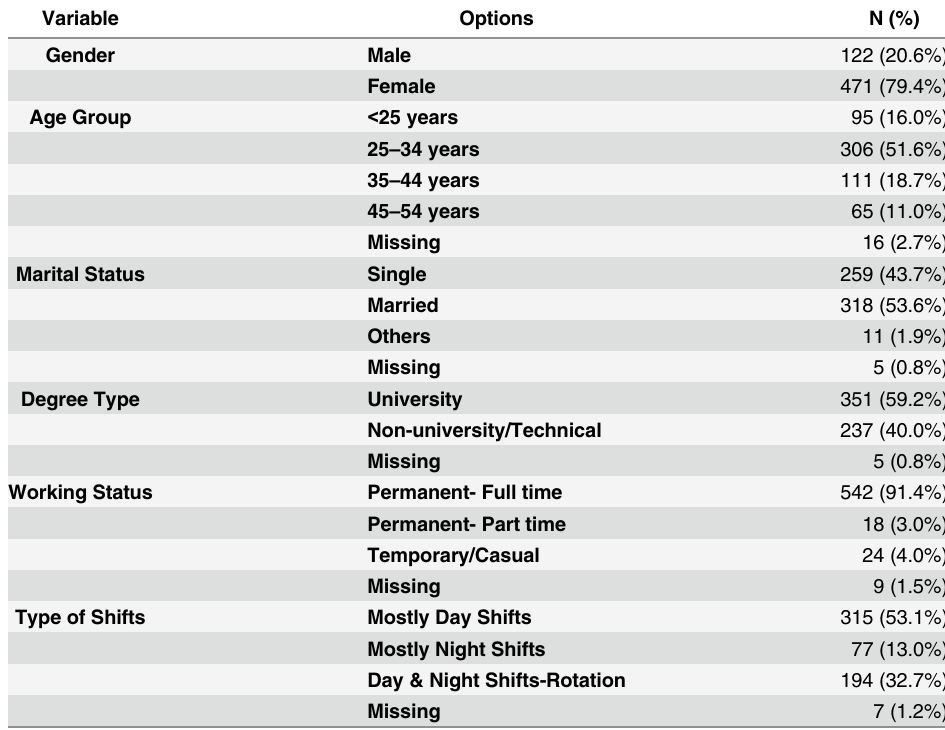
Table 1. Demographic and professional characteristics of survey respondents (n =